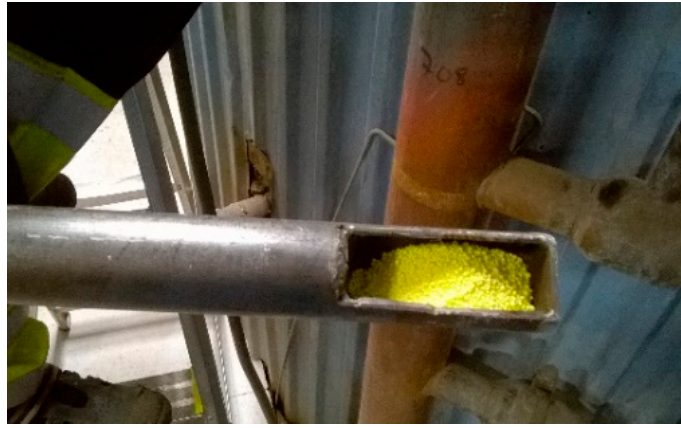
Figure 11. Batch probe for addition of sulfur granulates to the flue gas stream leaving the cyclone.